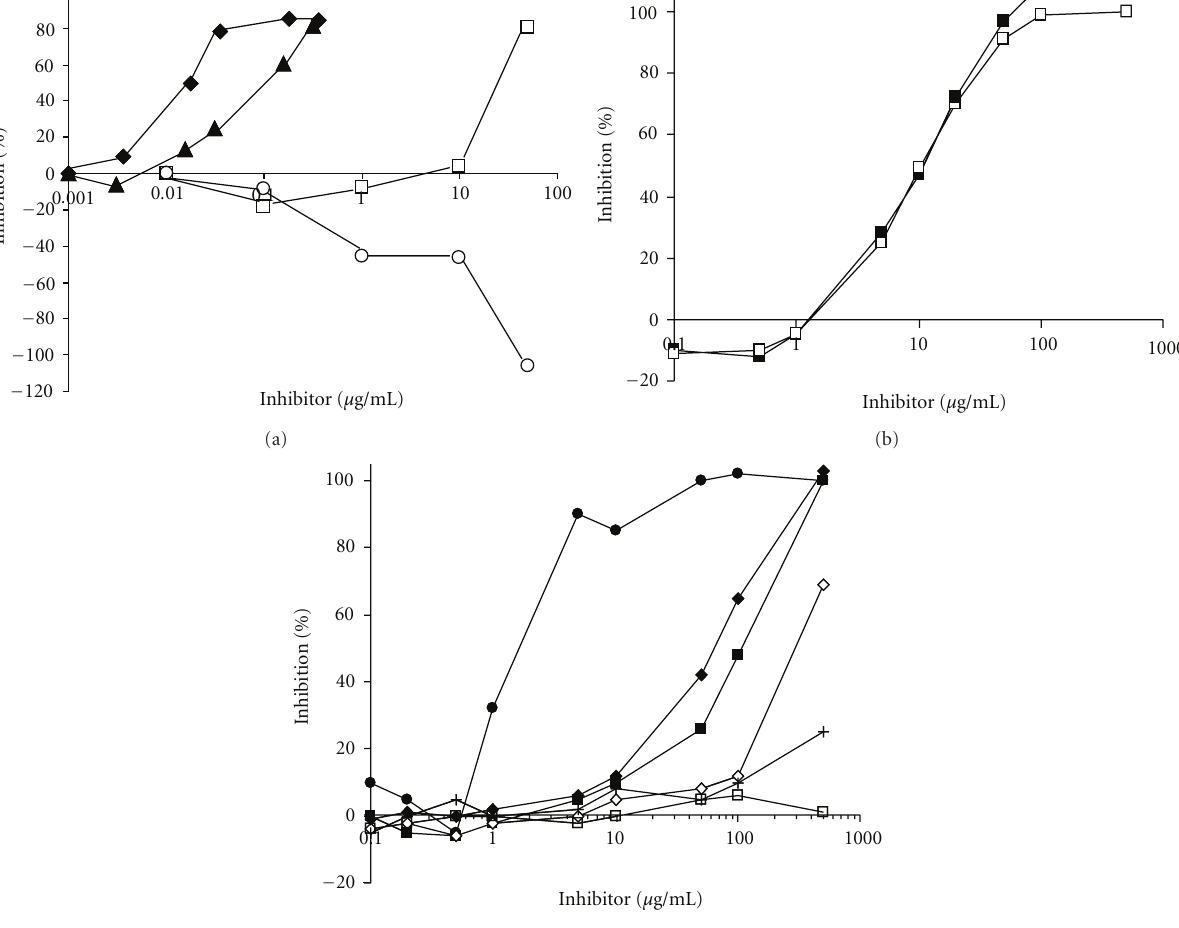
), flavocoxid ( ), (cid:2) (cid:4)